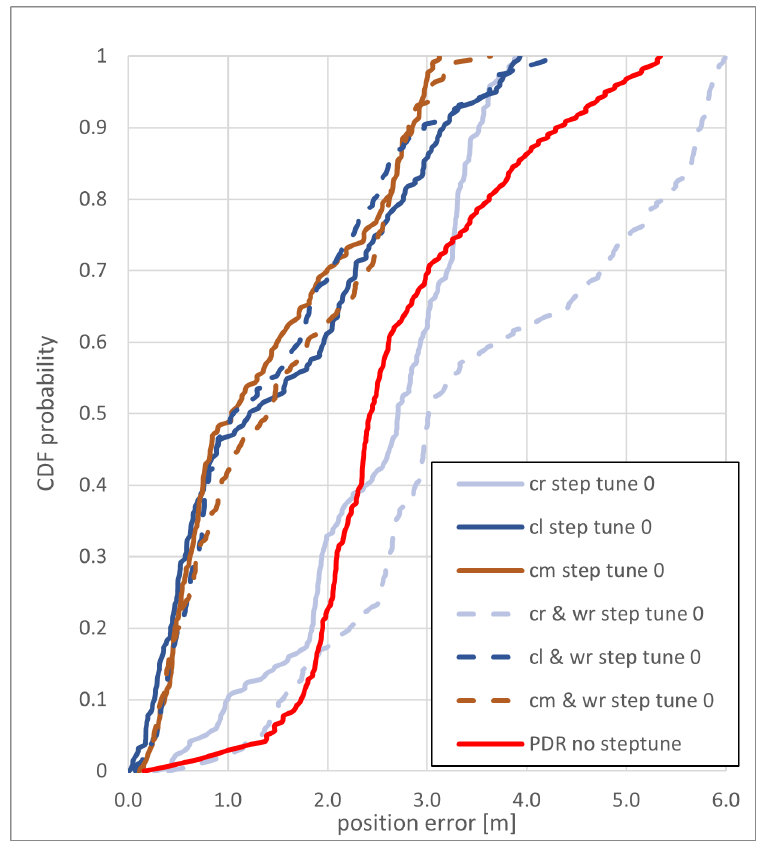
Figure 14. CDF of the positioning error of the eight path without step length correction for the backtracking PF and the PDR without step length correction.